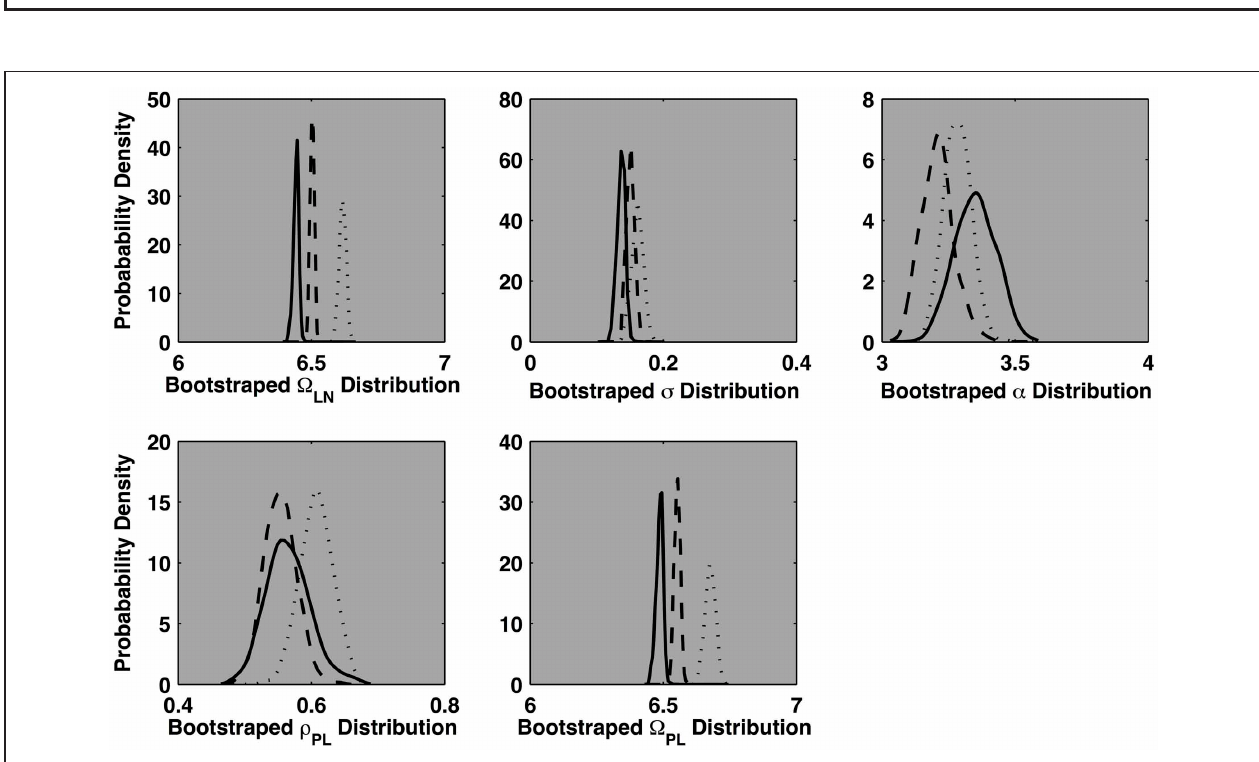
FIGURE 8 | Each plot depicts the bootstrapped distribution for each of five parameters of the cocktail model. The outcomes for the 0 ◦ , 60 ◦ , and 120 ◦ conditions are depicted as solid, dashed, and dotted lines, respectively. The bootstrapping procedure randomly resamples the empirical response time distributions 300 times, with replacement. The model is fit to each